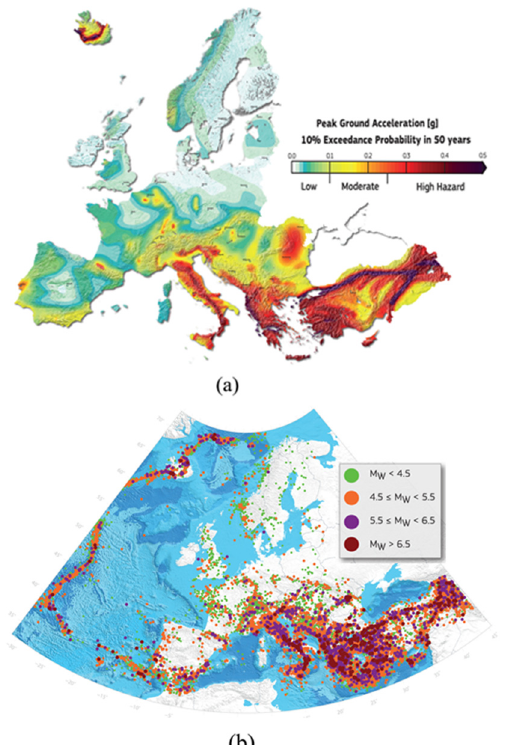
Figure 3. Seismic activity in Europe: (a) European seismic hazard map of 2013; (b) historical earthquake database for the period of 1000 to 2007 AD, with a magnitude range 1.7≤Mw≤8.5 for Europe, Central and Eastern Turkey, as compiled in the SHARE European Earthquake Catalogue (SHEEC) [4].